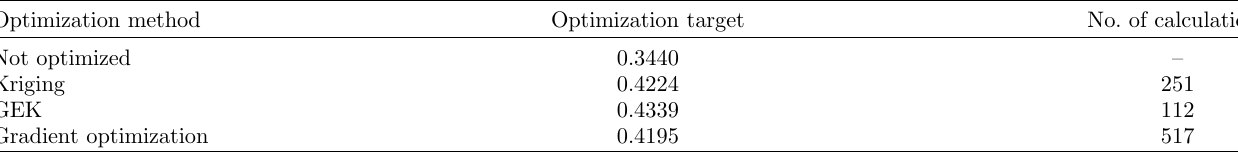
Table 3. Comparison of optimization methods at full frequency.